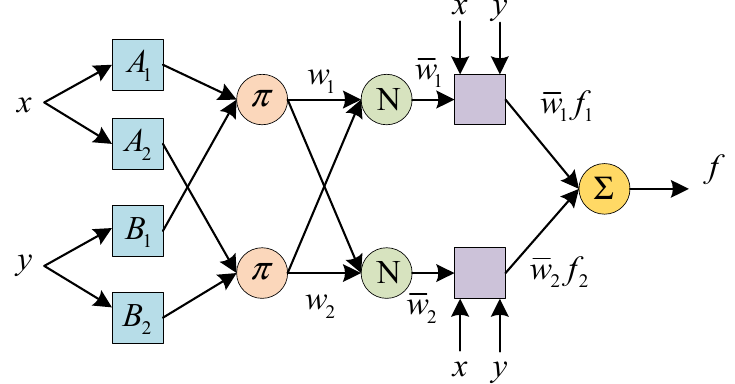
Figure 7. Structure diagram of ANFIS with two inputs.